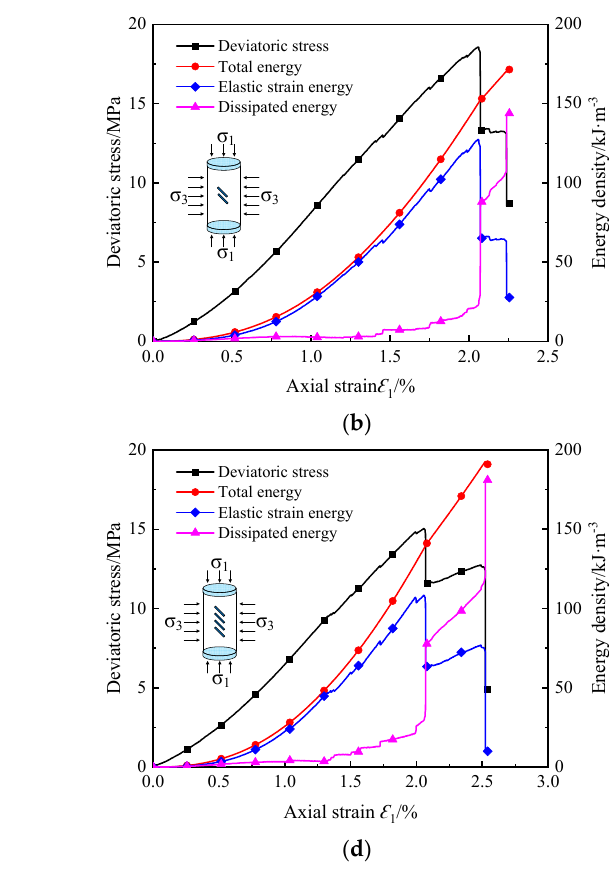
Figure 13. Energy evolution of coal specimens with different numbers of prefabricated cracks under confining pressure 0.3 MPa with axial strain. ( a ) Coal specimen M − 0.3 − 1; ( b ) Coal specimen M − 0.3 − 2; ( c ) Coal specimen M − 0.3 − 3; ( d ) Coal specimen M − 0.3 − 4. Table 2. Energy statistics at peak point of prefabricated cracked coal